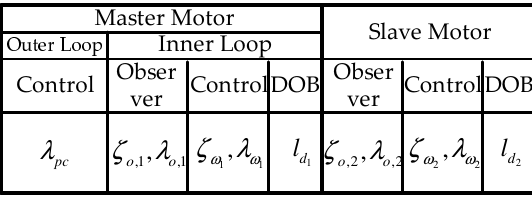
Figure 3. Design factors for the proposed